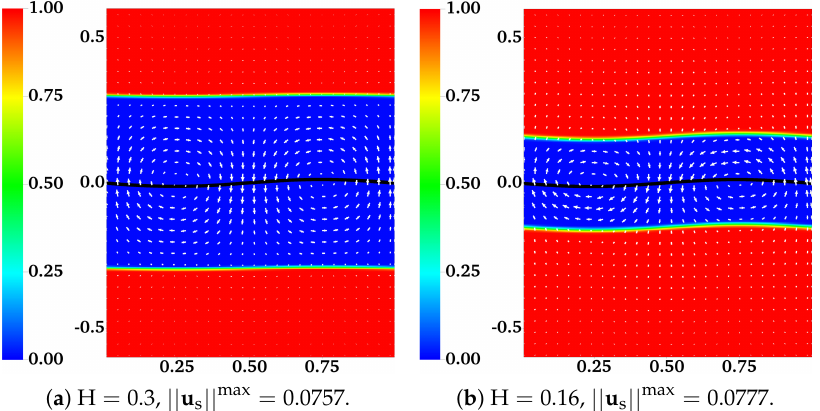
Figure 5. Distribution of network volume fraction θ n and fluid velocity u s at t = 0.5 for different H. All vectors have the same scale. The viscosity ratio between the two fluids is β =